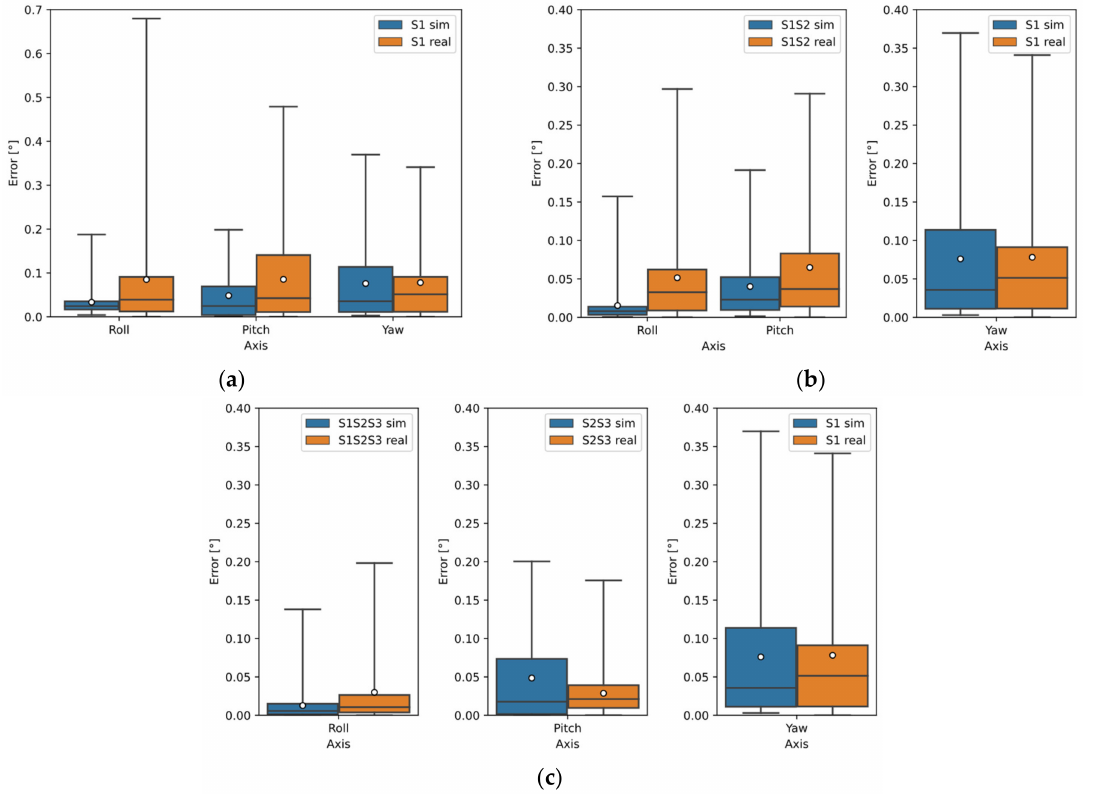
Figure 11. Comparison of results from simulation and real measurements of Object B: ( a ) using one sensor—S1; ( b ) configuration of two sensors: S1 and S2-S1S2 (Roll and Pitch detection), and S1 (Yaw detection); ( c ) configuration of three sensors—S1S2S3 (Roll detection), S2S3 (Pitch detection), and S1 (Yaw